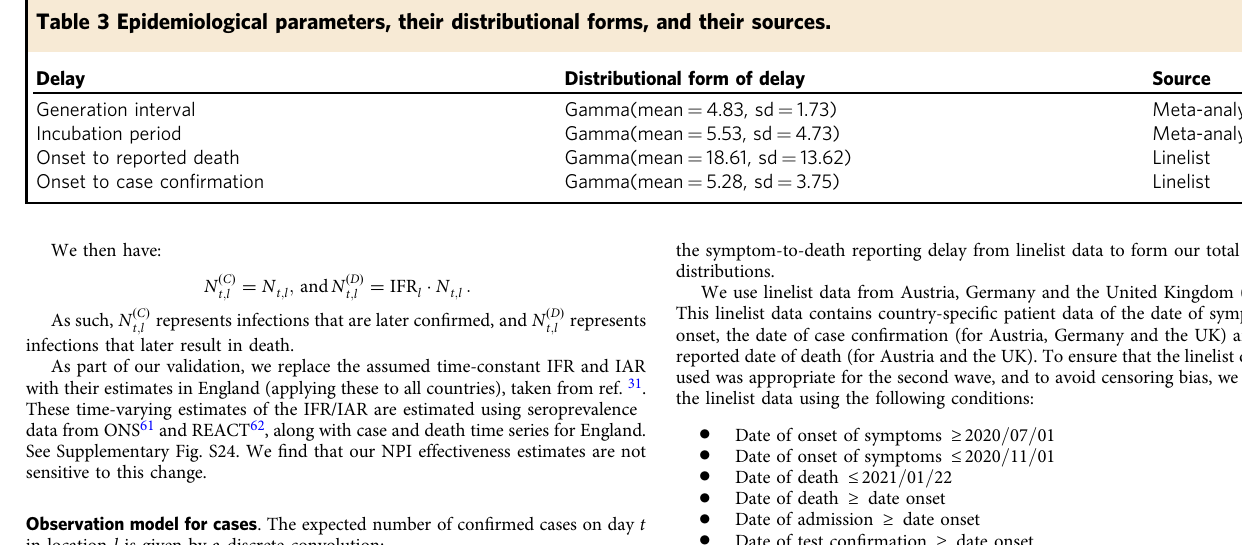
Table 3 Epidemiological parameters, their distributional forms, and their